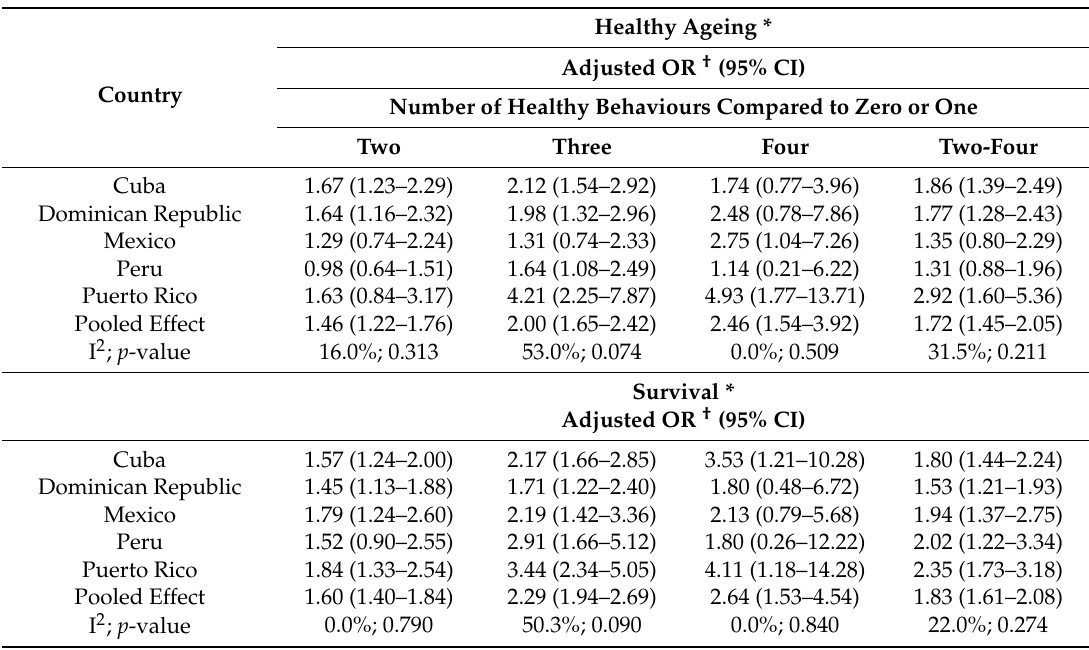
Table 3. Associations between number of healthy behaviours, healthy ageing and survival.